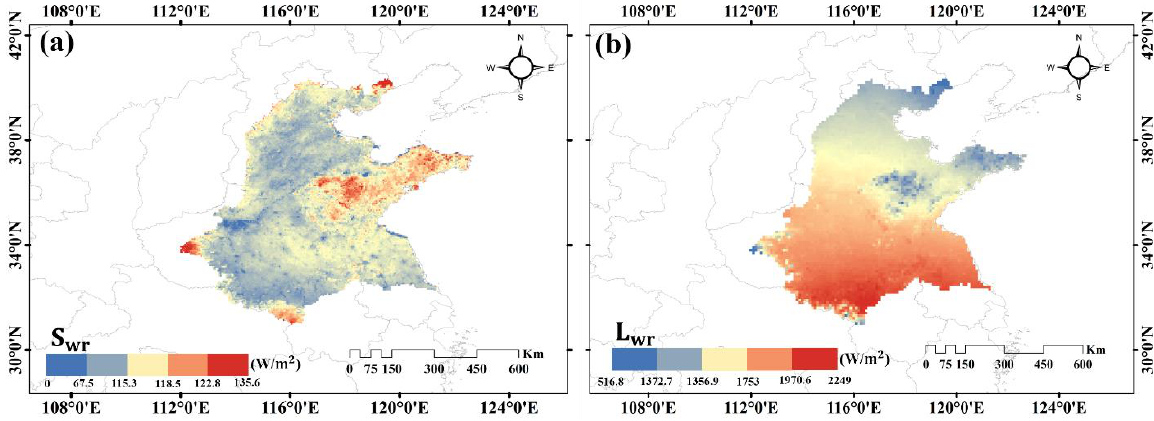
Figure 4. Spatial differences of ( a ) net shortwave radiation ( S wr ) and ( b ) net long-wave radiation ( L wr ) in the Huang – Huai-Hai River Basin from 2000 to 2015. (L wr ) in the Huang-Huai-Hai River Basin from 2000 to